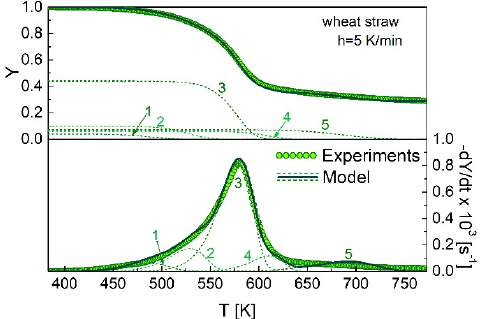
Figure 3. Predicted mass-loss rate for wheat straw (data in Table 2A,B), − dY/dt, and predicted rates of volatile release (dashed lines) from components n. 1–5 versus temperature (heating rate 5 K/min, up to 773 K).